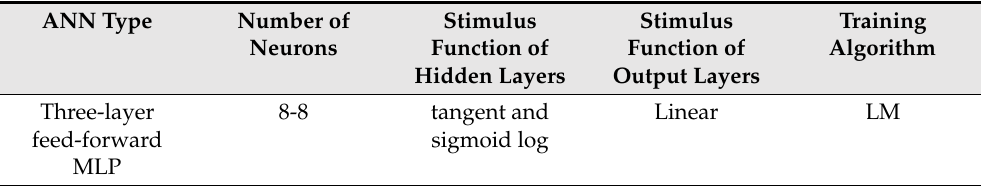
Table 4. Characteristics of the ANN in this